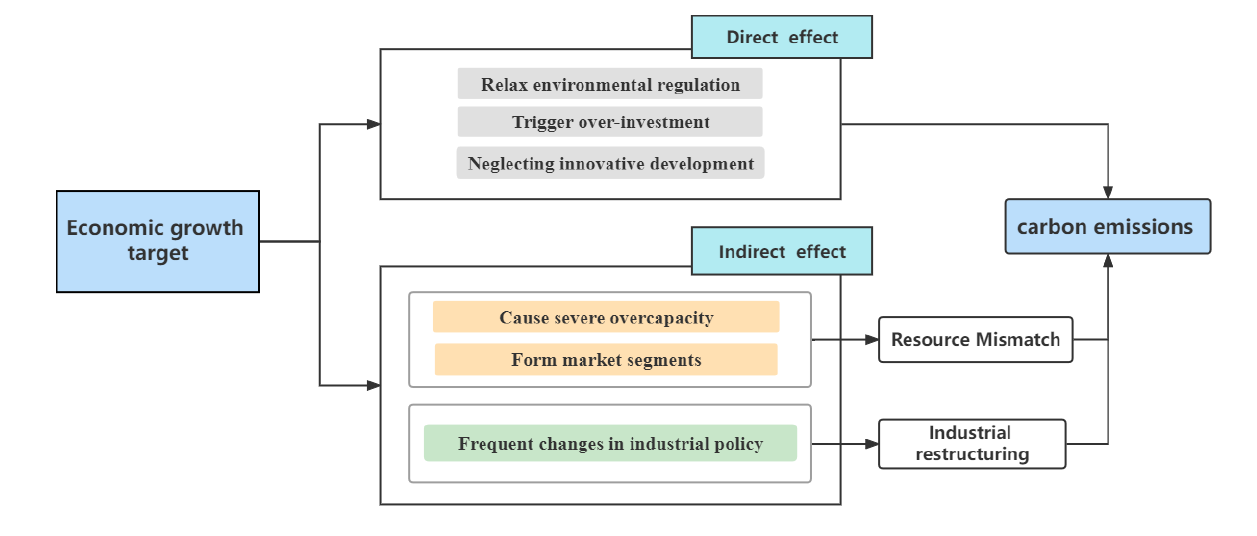
Figure 1. The roadmap of the theoretical mechanism.